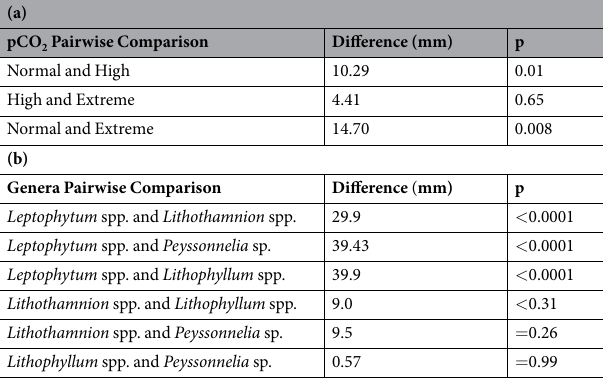
Table 3. Posthoc Tukey’s Honestly Signficant Difference (HSD) tests for algal growth following pCO 2 treatments for the model in Table 2a with algal growth as the response variable and CCRA genera and pCO 2 as predictor variables. Growth changes have been back transformed. (a) Growth differences by pCO 2 (b) growth differences by CCRA